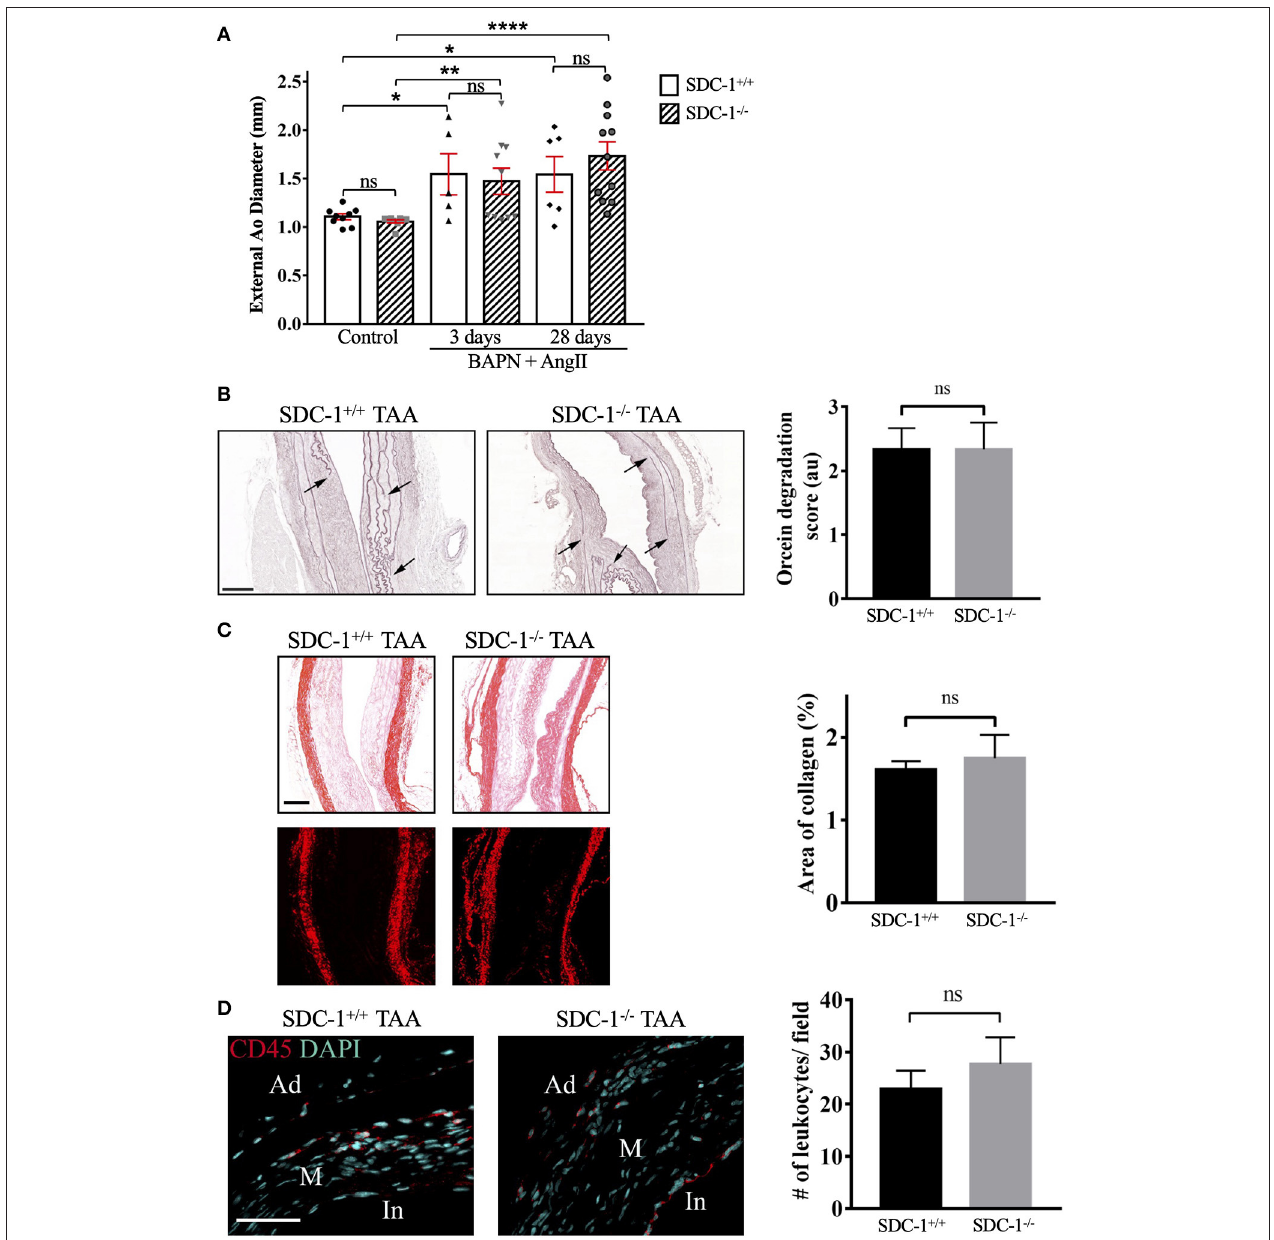
FIGURE 4 | SDC-1 deficiency does not alter the extent of aortic dilatation, ECM remodeling, or leukocytes recruitment in descending TAA in mice. (A) Measurement of external descending thoracic diameter in SDC-1 + / + and SDC-1 − / − mice that received BAPN and Ang II for 3 or 28 days or control (sham) mice. Aorta with a diameter ≥ 1.5mm was considered as an aorta that developed TAA. SDC-1 + / + or SDC-1 − / − control: n = 9 for both; SDC-1 + / + and SDC-1 − / − after 3 days: n = 5 and n = 10, respectively; SDC-1 + / + and SDC-1 − / − after 28 days: n = 6 and n = 11, respectively. (B) Elastin degradation. Representative images of orcein staining for SDC-1 + / + or SDC-1 − / − TAA specimens after 28 days following Ang II infusion and quantification of elastin degradation (to the right). Arrows show sites of elastic laminae degradation. SDC-1 + / + : n = 3, SDC-1 − / − : n = 6. Scale bar corresponds to 100 µ m. (C) Collagen deposition. Representative images of Sirius red staining for SDC-1 + / + or SDC-1 − / − TAA specimens after 28 days following Ang II infusion visualized by bright-field microscopy (upper images) or polarization microscopy (lower images) and its quantification (to the right) by image J software. Scale bar corresponds to 100 µ m. (D) CD45 expression. Representative immunofluorescence images of TAA specimens after 28 days of Ang II infusion stained with Ab against CD45 and counterstained with DAPI and its quantification (to the right) by Image J software. In, intima; M, media; Ad, adventitia. Scale bar corresponds to 50 µ m. (C,D) SDC-1 + / + : n = 3, SDC-1 − / − : n = 7. (A–D) Data are presented as mean ± SEM and p -values were calculated using non-parametric two-tailed Mann-Whitney test; * p < 0.05, ** p < 0.01, **** p < 0.0001, ns: not significant.